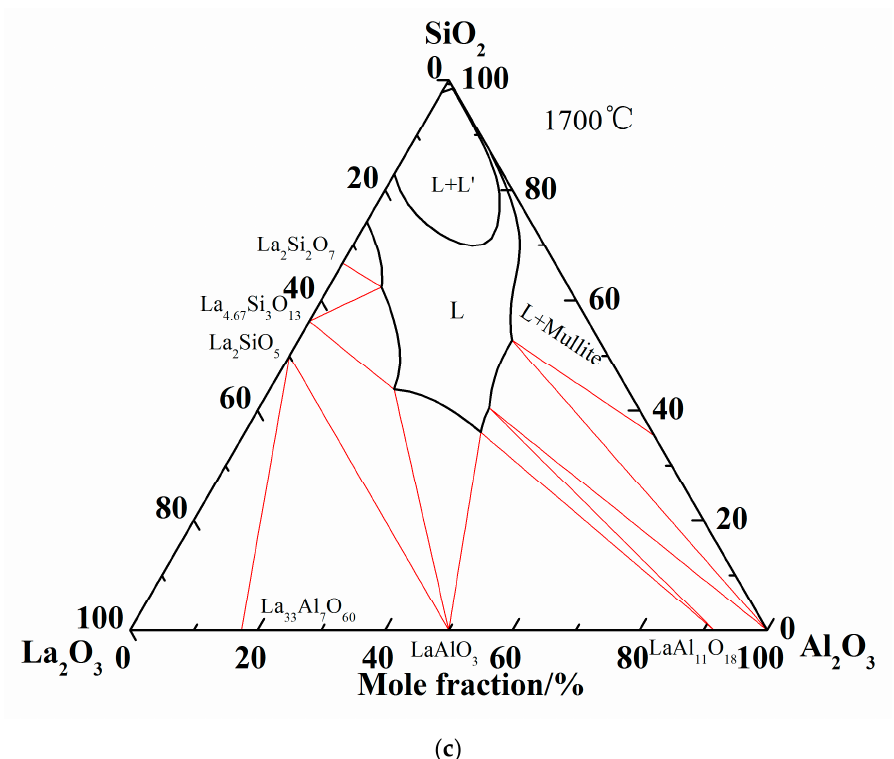
Figure 6. More calculations of Al 2 O 3 -SiO 2 -La 2 O 3 ternary phase diagram. ( a ) Isothermal curves of Al 2 O 3 -SiO 2 -La 2 O 3 system; ( b ) Isothermal section of Al 2 O 3 -SiO 2 -La 2 O 3 system at 1600 ℃ ; ( c ) Isothermal section of Al 2 O 3 -SiO 2 -La 2 O 3 system at 1700 ℃.